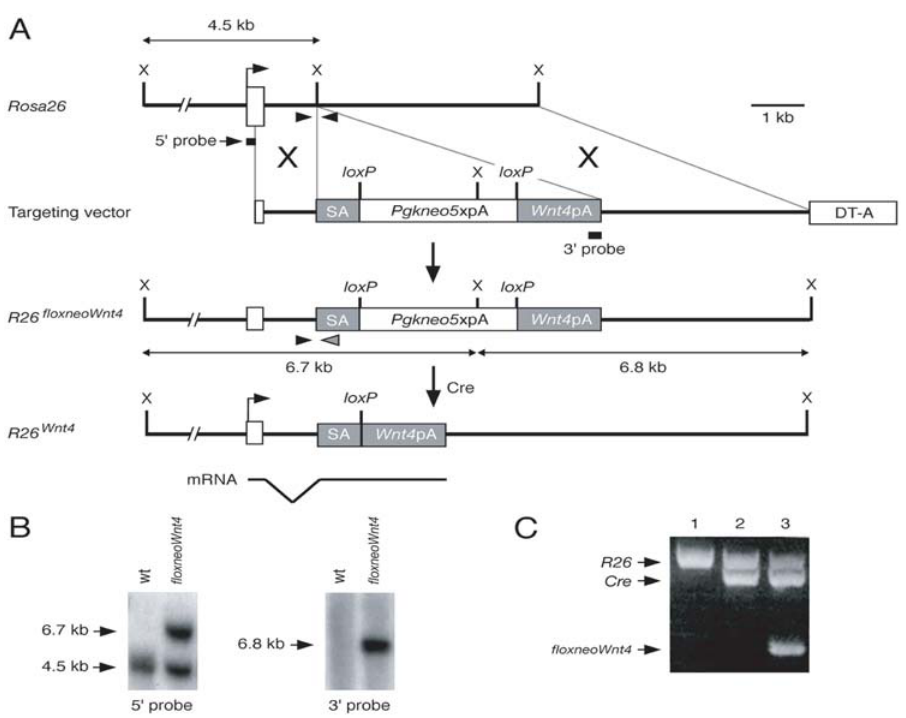
Figure 1. Generation of R26 floxneoWnt4 mice. A, Gene targeting strategy. Open box, R26 exon 1; DT-A, diphtheria toxin expression cassette. SA, splice acceptor; X, Xba I. B, Southern analysis of ES cell clones. Genomic DNAs were digested with Xba I and detected by 5 9 external or 3 9 internal probes. C, PCR genotyping of R26 floxneoWnt4 ; Col2a1-Cre mice. Primers shown in panel A (arrowheads) amplify R26 wild-type ( , 600-bp) and targeted ( , 350-bp) alleles. Cre -specific primers yield a , 550-bp band to identify mice carrying the Col2a1-Cre transgene.